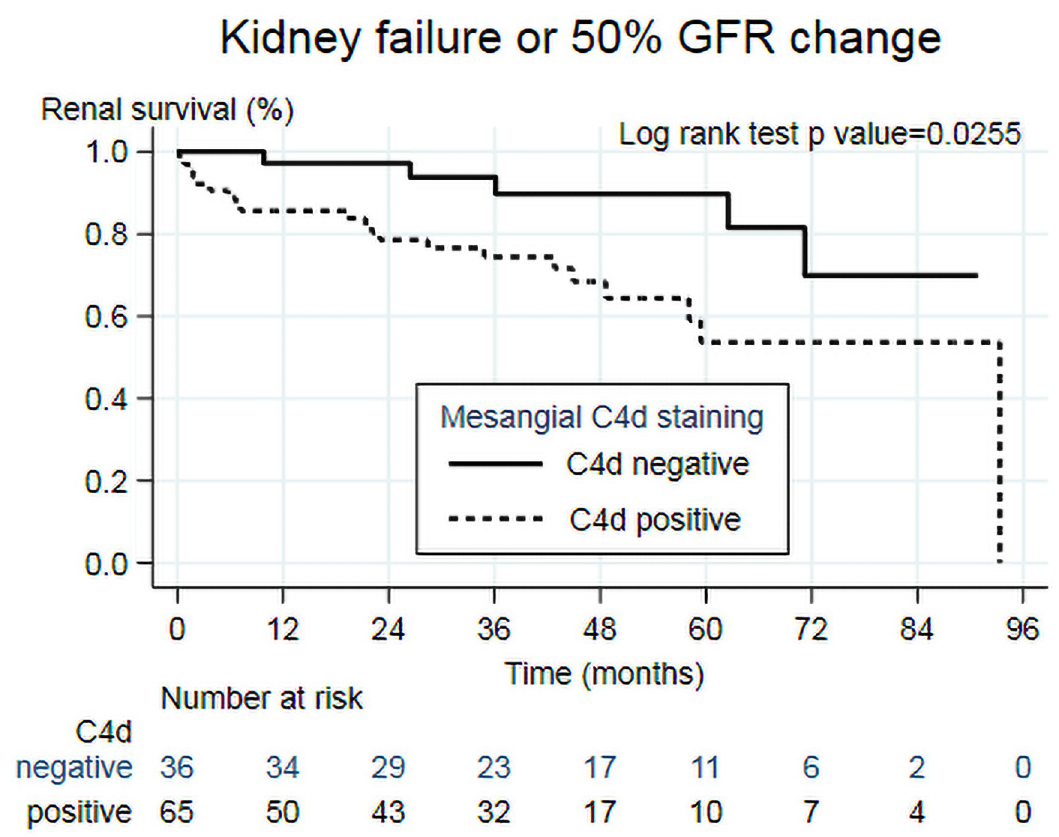
Fig 2. Kaplan-Meier analysis of mesangial C4d staining (positive vs negative) on primary outcome (Kidney Failure or Δ